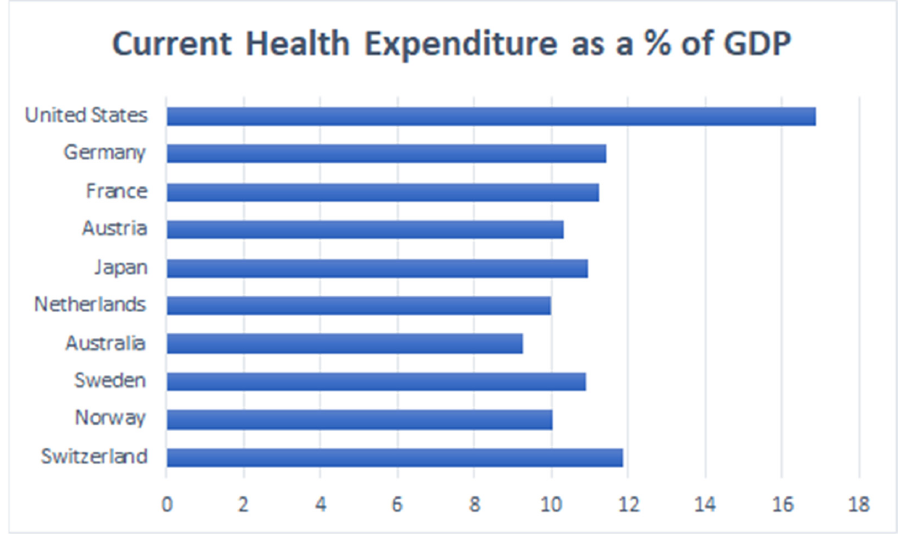
Figure 8. Current Health Expenditures as percentage of GDP, 2018. (Source: Adapted from the World Bank Database) [44].